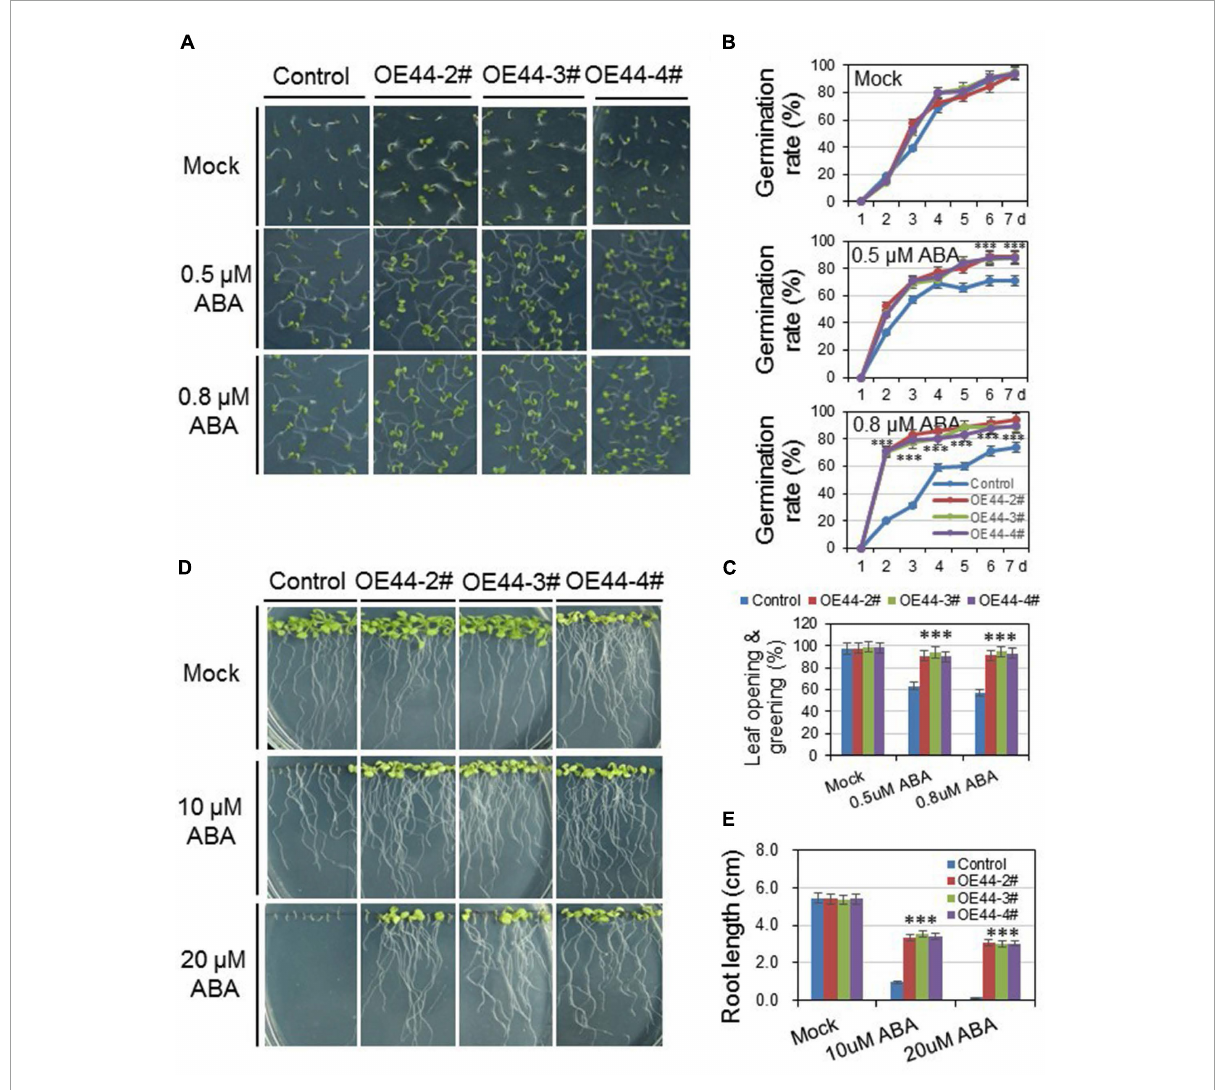
FIGURE7 Overexpression of HcWRKY44 in Arabidopsis was insensitivity to ABA. (A–C) The seed germination rate and leaf opening and greening rate of HcWRKY44 transgenic lines and control lines were analyzed on 1/2 MS with or without ABA supplement. (D,E) Five-day-old seedlings grown on blank media were transferred onto new plates supplemented with 0, 10, and 20 µ M ABA to investigate the ABA sensitivity between HcWRKY44 transgenic lines and control lines. All values are means ( ± SD) from three independent experiments. ∗∗∗ P < 0.01 represented the significant differences by Student’s t